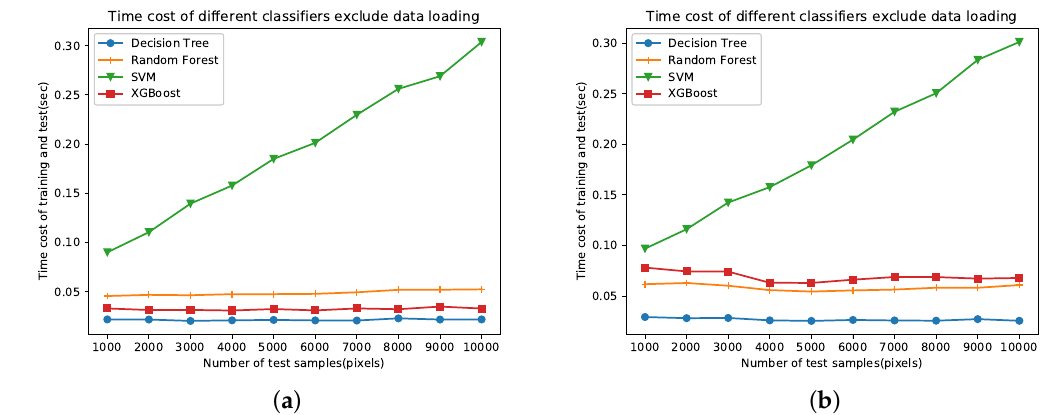
Figure 11. Comparison of time costs on data sets A and B. ( a ) Data set A. ( b ) Data set B.